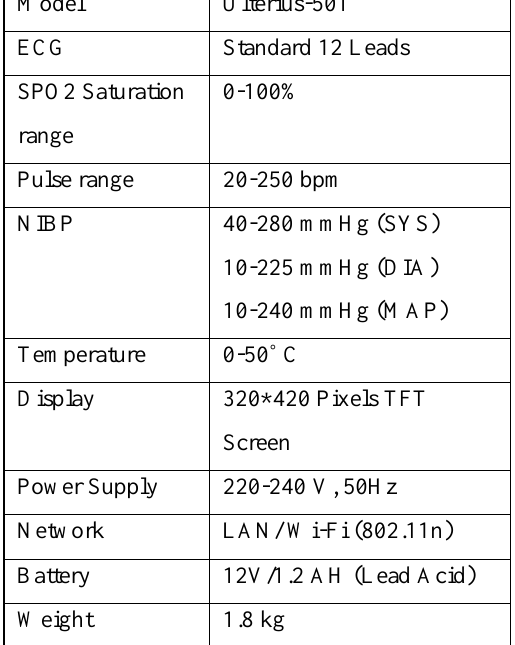
Table 1. Specification of the Vital Sign Monitor Model